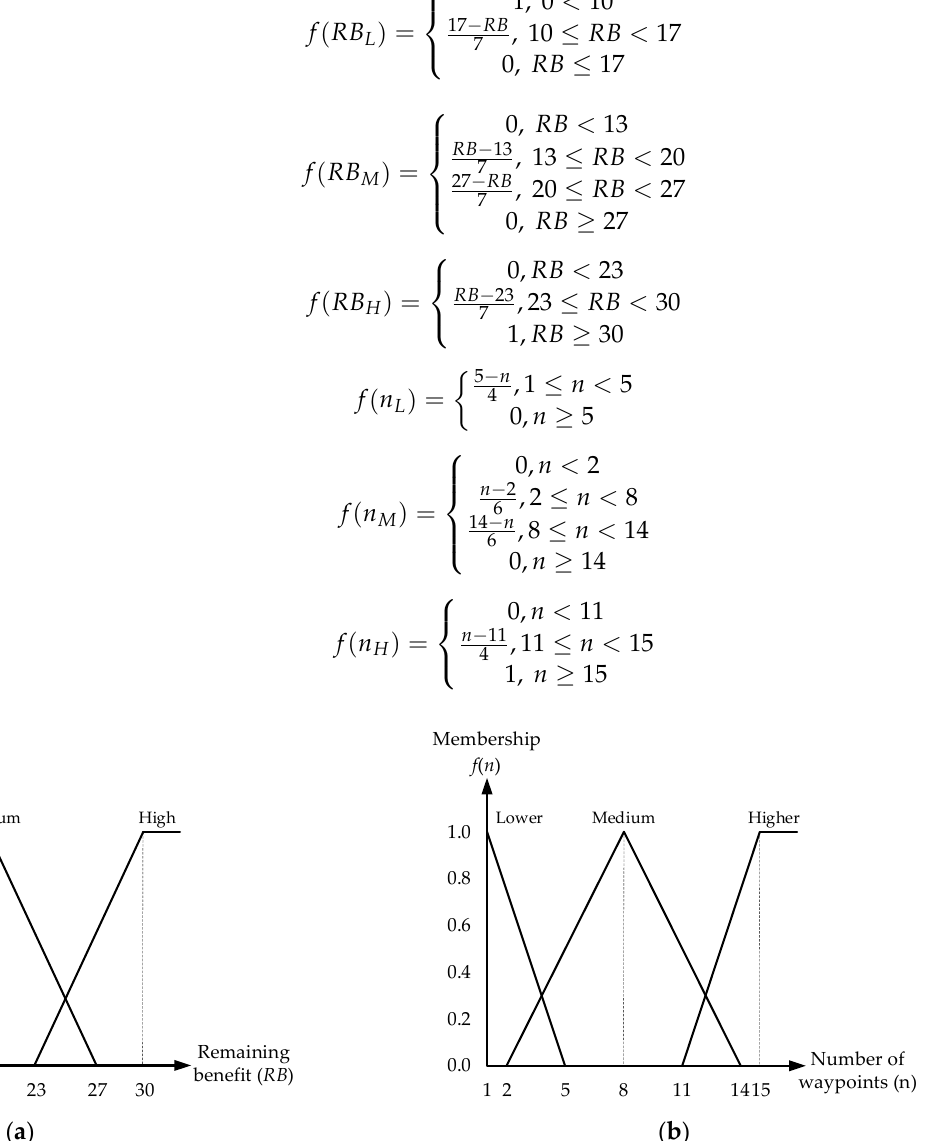
Figure 5. Schematic diagram of the membership function of variables: ( a ) the remaining benefit and ( b ) the number of waypoints.